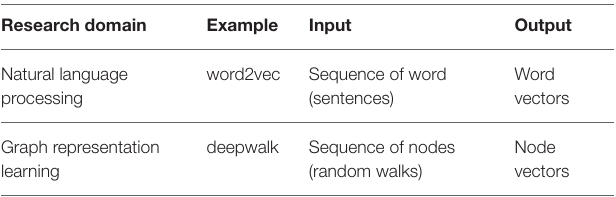
TABLE 2 | Comparison between language model word2vec and graph model Deepwalk.